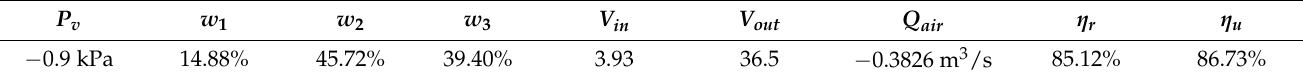
Table 3. Statistics on the recovery information of the spherical recovery hood at a negative inspiratory pressure of − 0.9 kPa at 1.0